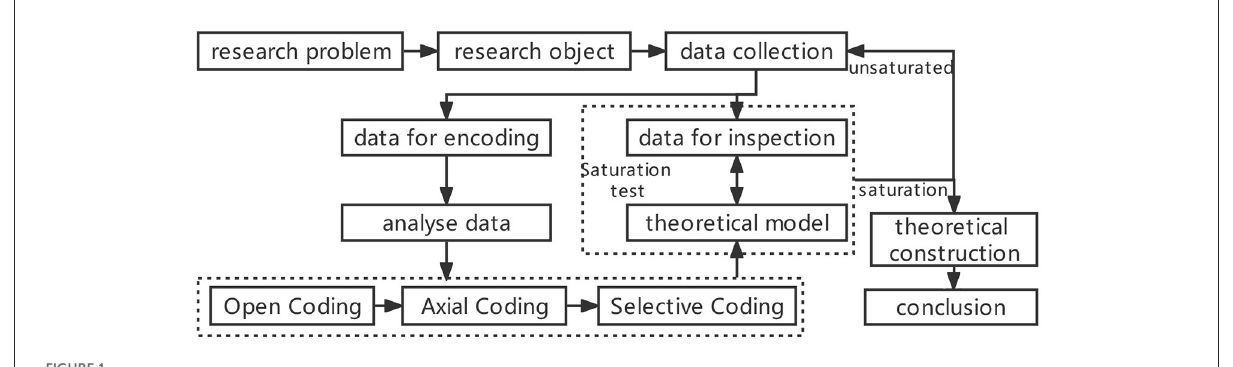
FIGURE1 Grounded theory research process.